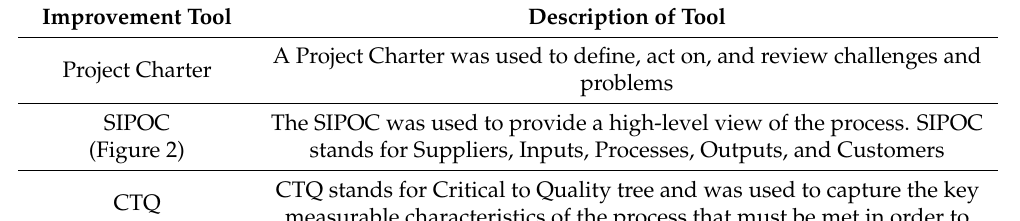
Table 2. The Lean Six Sigma Tools utilised in the project. Improvement Tool Description of Tool